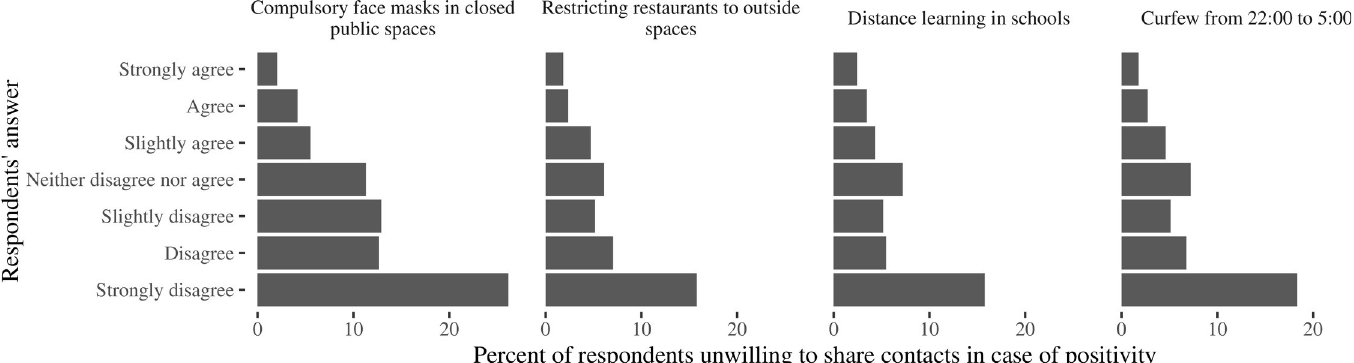
Fig 7. Percent of respondents who expressed unwillingness to share contacts in case of positivity, according to their response to the questions “Please indicate your opinion about the following anti-epidemic measures”. The measures are named at each panel on the figure.